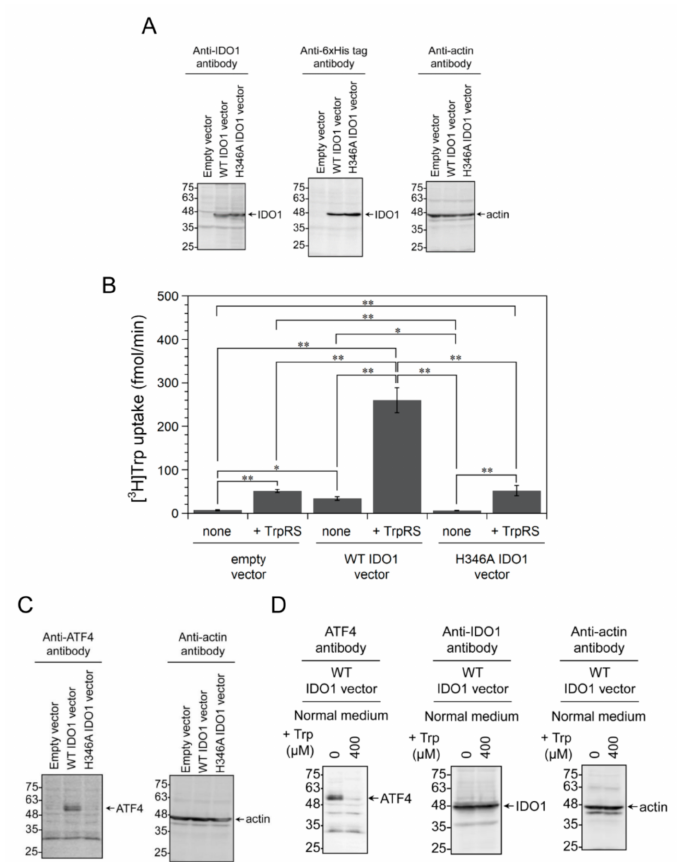
Figure 2. The e ff ect of adding human TrpRS protein to the assay bu ff er on [ 3 H]Trp uptake into HeLa cells overexpressing 6 × His-tagged human indoleamine 2,3-dioxygenase 1 (IDO1). Control vector, human wild-type (WT) IDO1 or H346A IDO1 mutant expression vector was transfected into cells. ( A ) Western blot analysis of extracts from 6 × His-tagged human IDO1-overexpressing cells using anti-IDO1, anti-6 × His tag, and anti- β -actin antibodies. The arrows indicate the expected position of IDO1 and β -actin. Molecular size markers (kDa) are shown on the left. ( B ) [ 3 H]Trp uptake into HeLa cells, in which human WT IDO1 or H346A IDO1 mutant was overexpressed, in the absence or presence of human TrpRS protein. All data are expressed as mean ± SD of at least four independent experiments. ** p < 0.01, * p < 0.05. ( C ) Western blot analysis of extracts from 6 × His-tagged human IDO1-overexpressing cells using anti-activating transcription factor 4 (ATF4) or anti- β -actin antibodies. The arrows indicate the expected positions of ATF4 and β -actin. Molecular size markers (kDa) are shown on the left. ( D ) Western blot analyses of extracts of 6 × His-tagged human WT IDO1-overexpressing HeLa cells, which were incubated in normal medium with additional Trp (0 or 400 µ M Trp) for 18 h, by using anti-ATF4, anti-IDO1, and anti- β -actin antibodies. Final concentration of Trp in the medium is 80 or 480 µ M, because normal medium contains 80 µ M